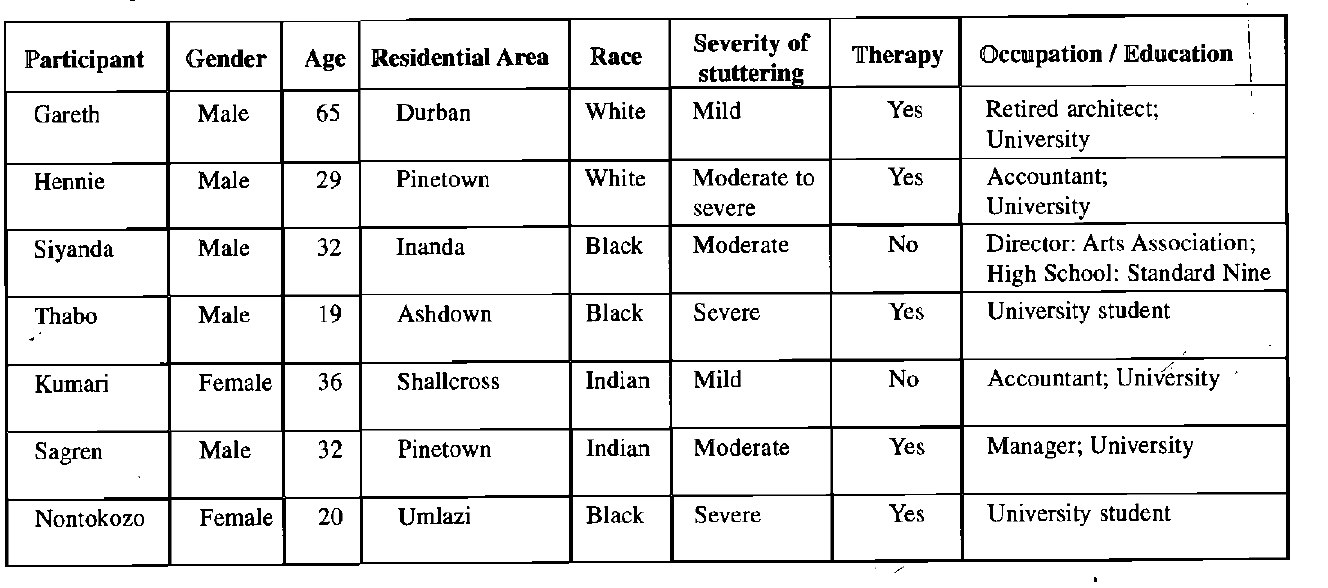
Table 1: Biographical profiles of participants